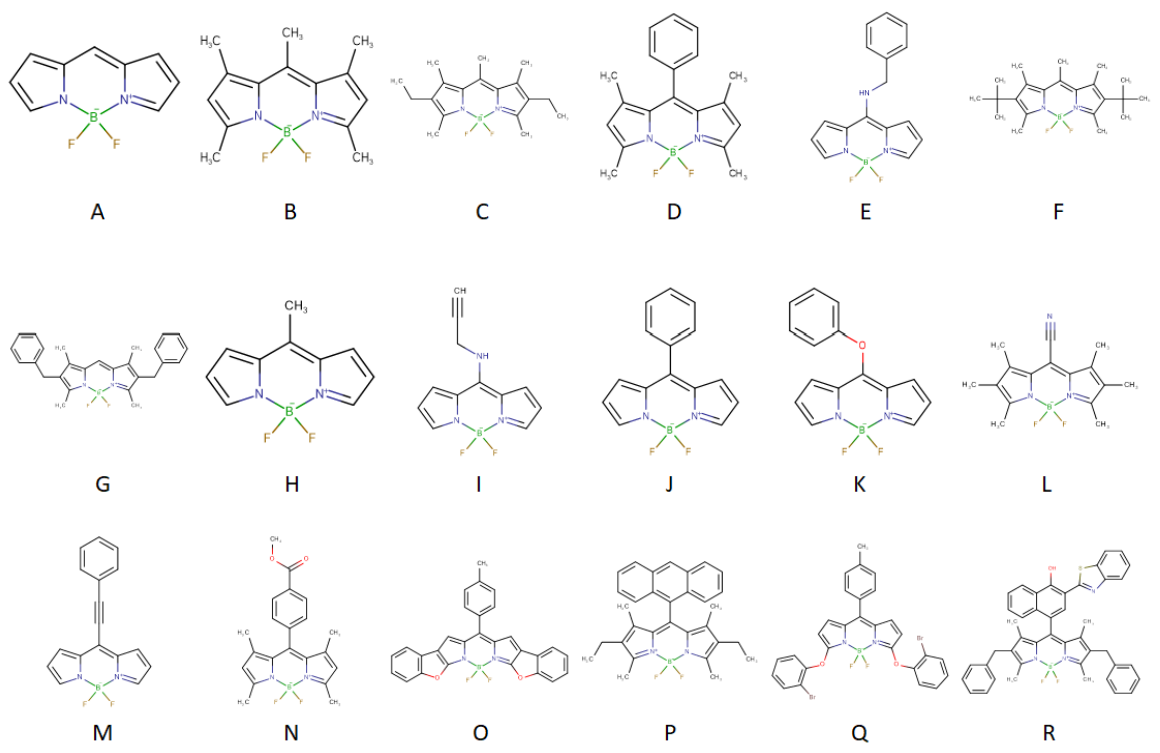
Scheme 11. Chemical structure of the duplicates of the target dataset studied in the current research.